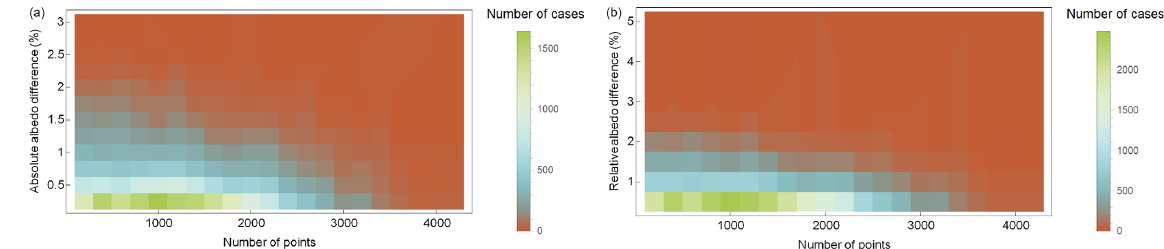
Figure 4. The relationship between the number of points in the cloud distribution and the simulated mean (a) and relative mean (b) albedo accuracy.